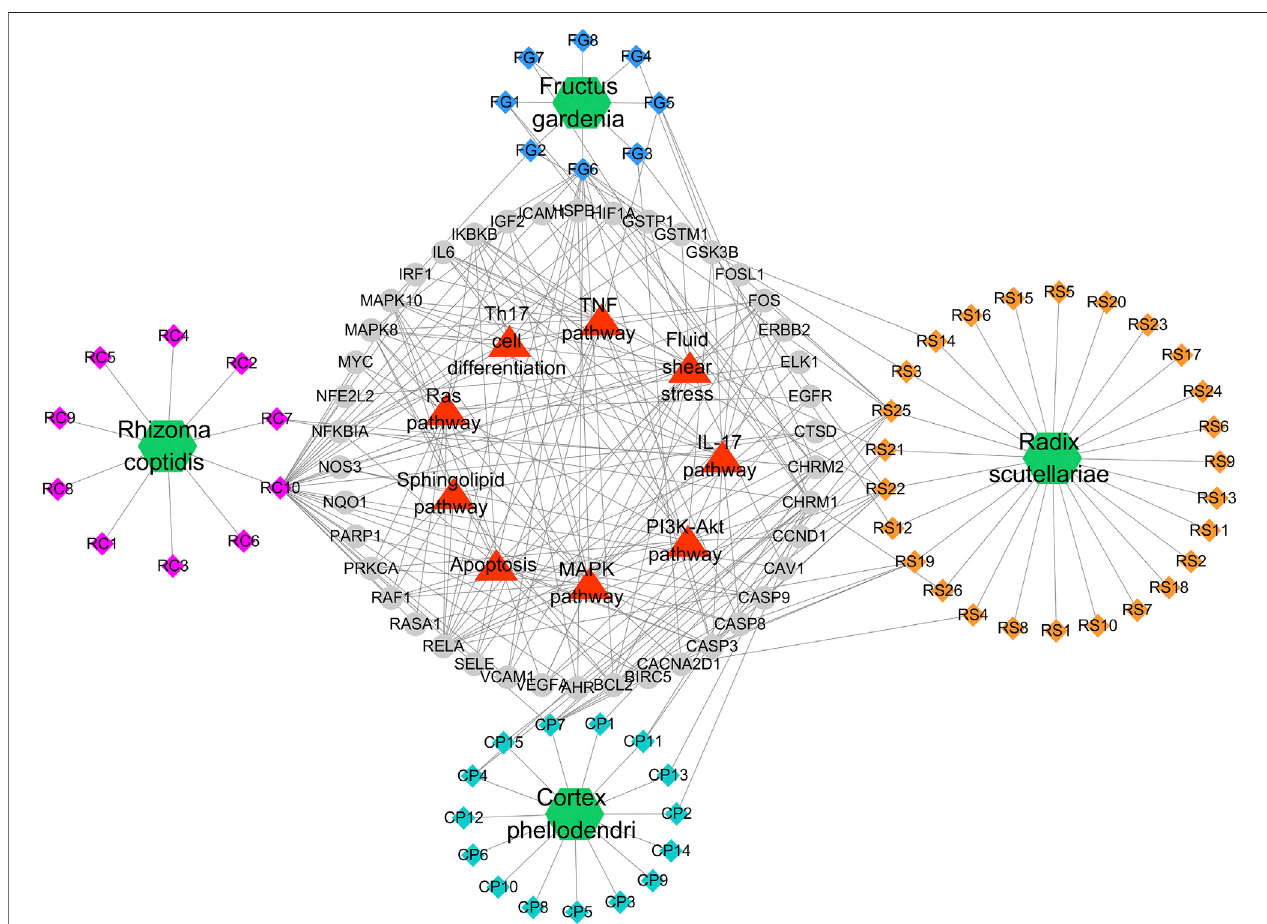
FIGURE 4 | Potential Compound-Targets-Pathway (pC-T-P) network of HLJDT in the treatment of MI. There were 4 kinds of herbs, 59 compounds, 42 predicted targets and 9 signaling pathways on the network. Green hexagon represents 4 kinds of herbs of in HLJDT, every color represents the single medicine. Diamond represents compounds, each color represents one herb in HLJDT; Gray circle represents potential targets, while the red triangle represents the predicted signaling pathways. RC, Rhizoma coptidis; RS, Radix scutellariae; CP, Cortex phellodendri; FG, Fructus gardenia .